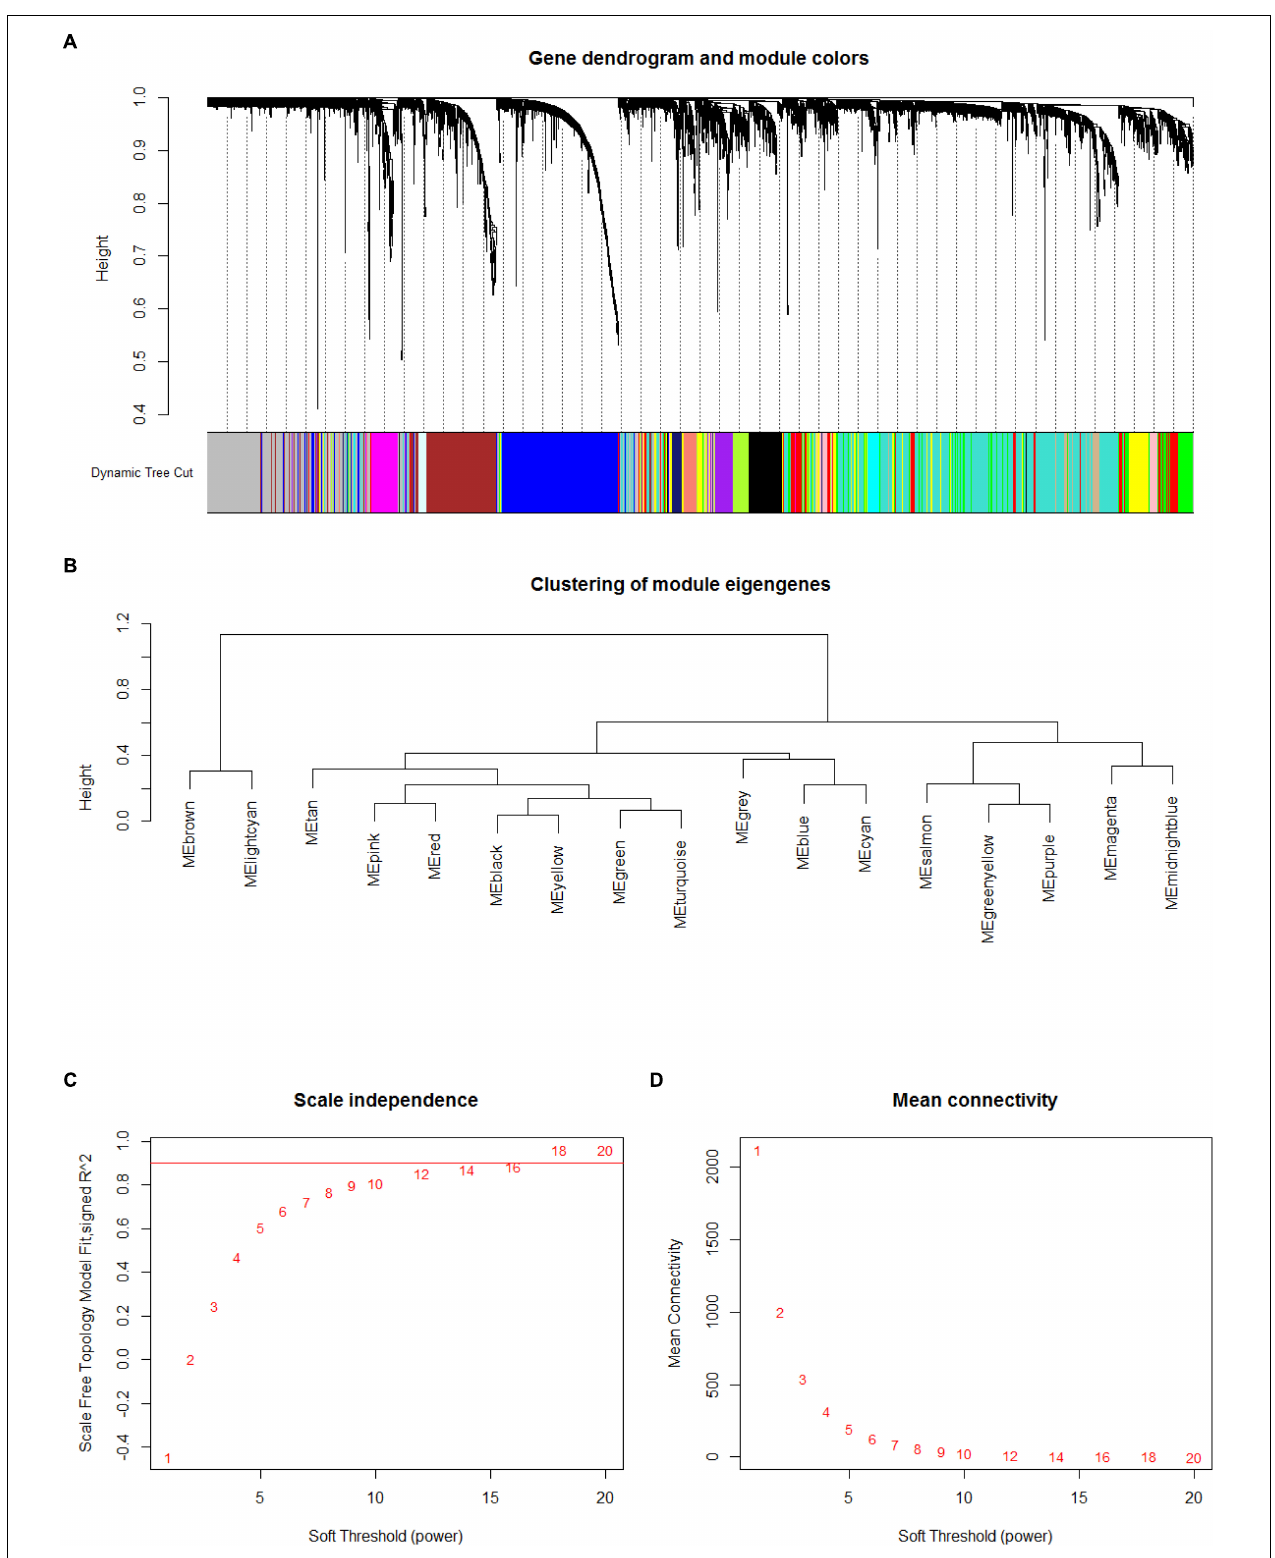
FIGURE 2 | Result of weighted gene correlation network analysis (WGCNA) analysis. (A,B) Cluster result and trait heatmap of data samples (A) and determination of parameter β of the adjacency function in the WGCNA algorithm (B) . (C) The scale independence of WGCNA analysis. (D) The mean connectivity of WGCNA analysis.